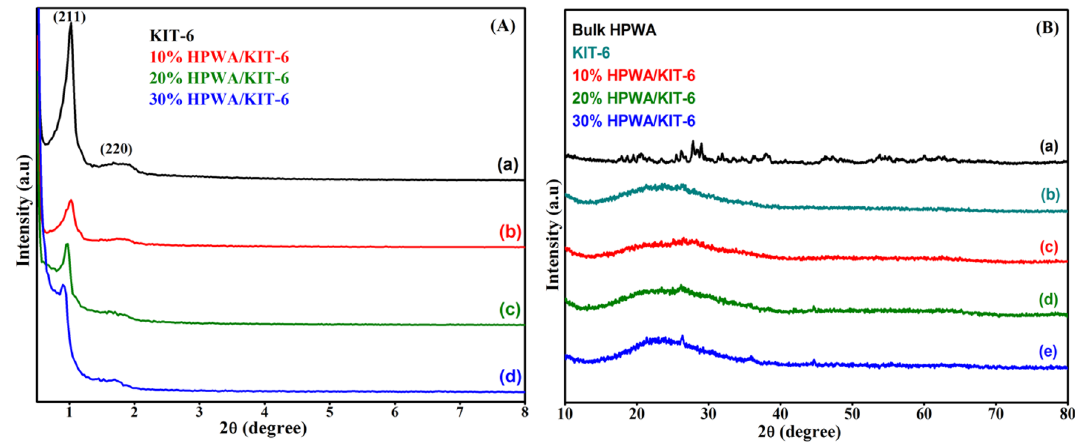
Fig. 1 XRD pattern of KIT-6 and heteropoly acid (HPWA)-supported KIT-6 catalysts. a Low-angle XRD pattern. b High-angle XRD pattern Table 1 Textural properties, surface acidity, and metal content of support and supported catalysts